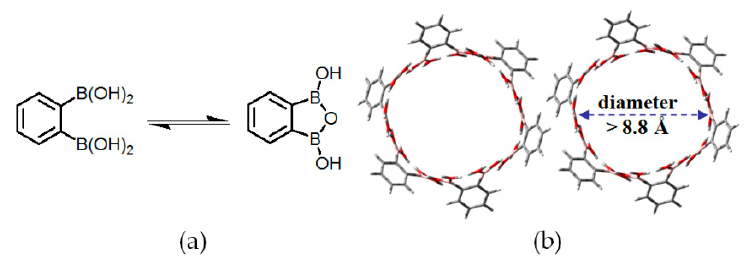
Figure 6. ( a ) Reaction equilibrium between 1,2-diphenylene-diboronic acid and 1-sanh in water; ( b ) Hexagonal channels formed in the nanotubular structure of H5 .